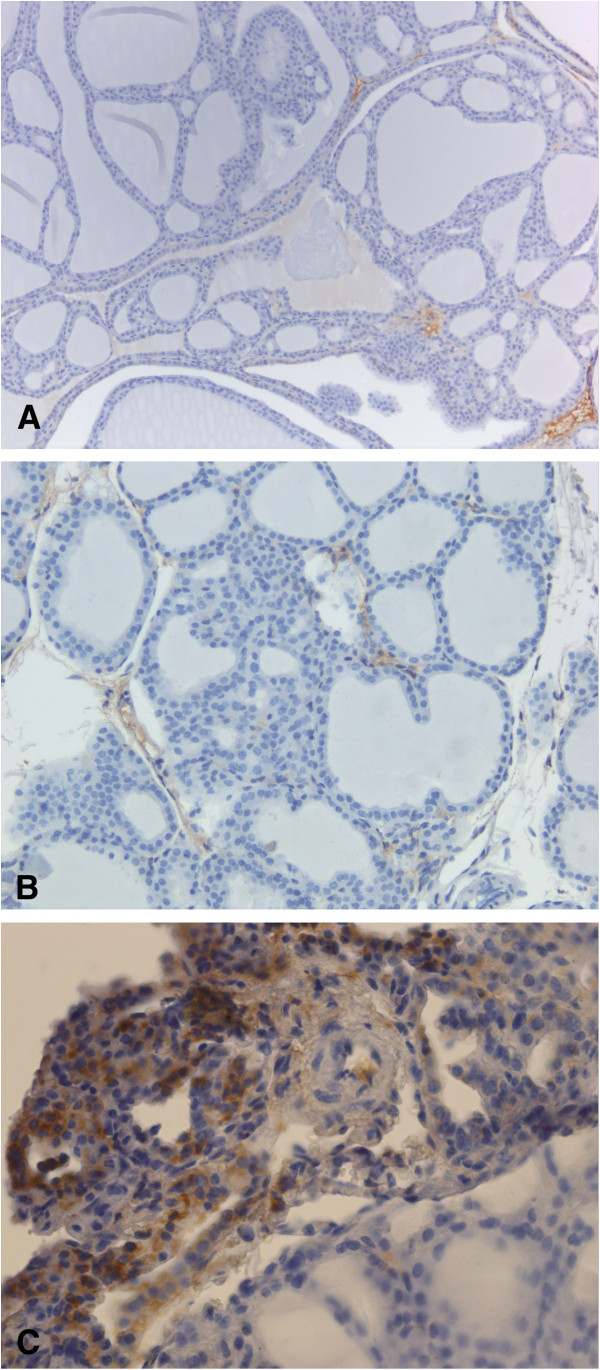
Representative microphotographs of immunohistochemistry analysis of murine thyroid stained with antibodies against VEGFR type 2 receptor. Brown color indicate presence of VEGFR2. Low grade expression of VEGFR-2 in normal thyroid (A), in thyroid adenoma (B) and high grade expression in thyroid carcinoma (C).